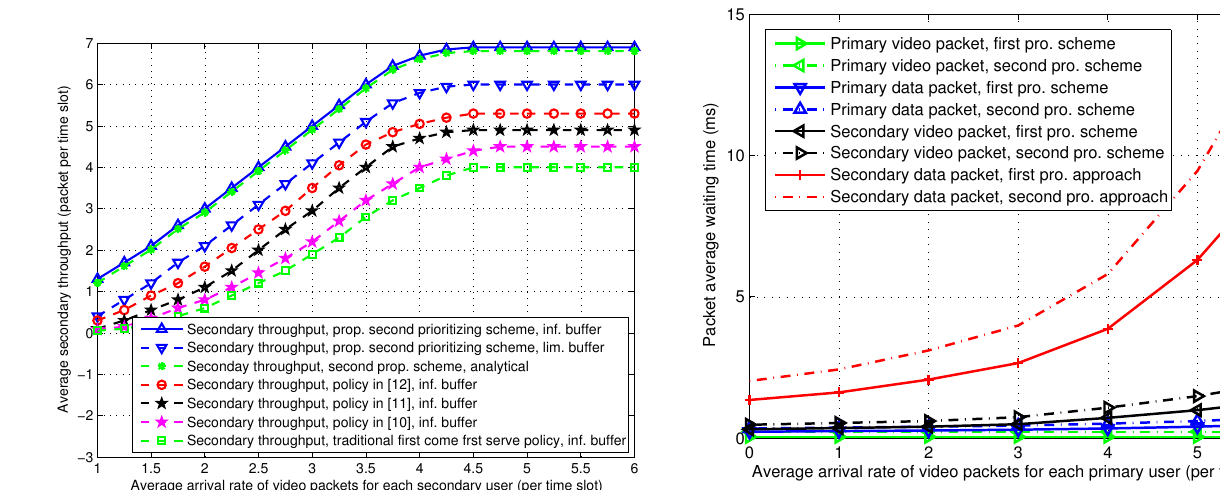
Figure 7. Experimental and analytical results of the secondary throughput for second prioritization scheme in our proposed MAC scheme.